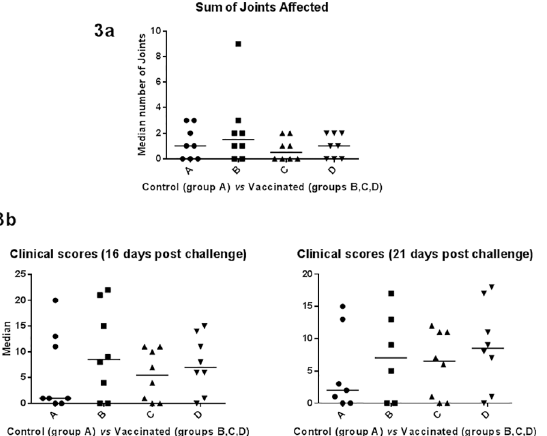
Fig 3. Affected joints and clinical symptoms in response to infection with H . somni . ( 3a) Sum of joint lesions among control group A vs vaccinated groups B, C and D animals measured from day 1 to 21 post challenge. ( 3b ) Sum of clinical scores measured from day 1 to 16 post challenge or day 1 to 21 days post challenge. Two animals in group (B) were euthanized on day 17 post challenge due to being severely